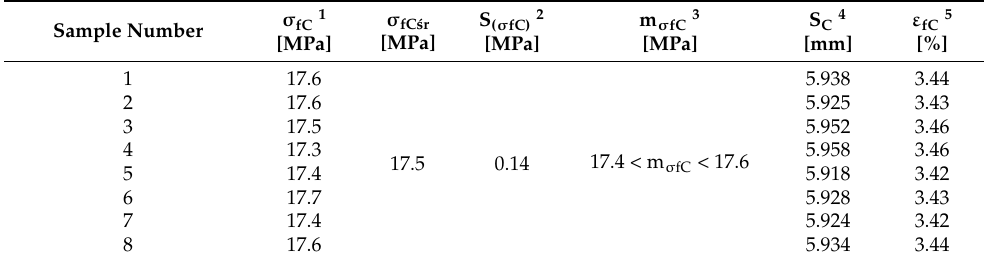
Table 2. Results of flexural stress determination at conventional bend σ fC for a population of 8